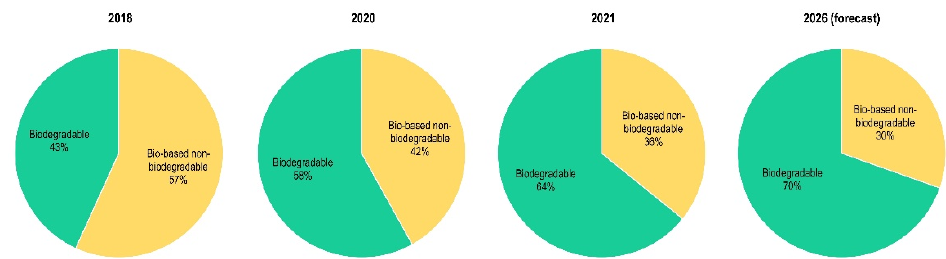
Figure 3. Bioplastics market trend from 2018–2026 (adapted from European Bioplastics and nova- Institute [21,22,25]).